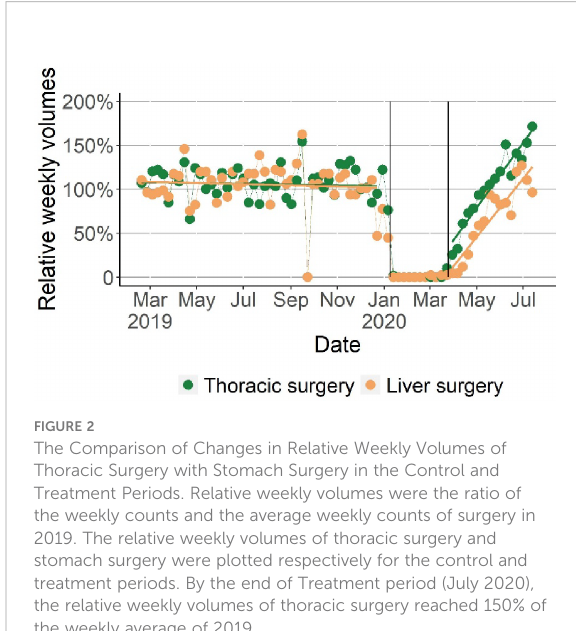
FIGURE 2 The Comparison of Changes in Relative Weekly Volumes of Thoracic Surgery with Stomach Surgery in the Control and Treatment Periods. Relative weekly volumes were the ratio of the weekly counts and the average weekly counts of surgery in 2019. The relative weekly volumes of thoracic surgery and stomach surgery were plotted respectively for the control and treatment periods. By the end of Treatment period (July 2020), the relative weekly volumes of thoracic surgery reached 150% of the weekly average of 2019.